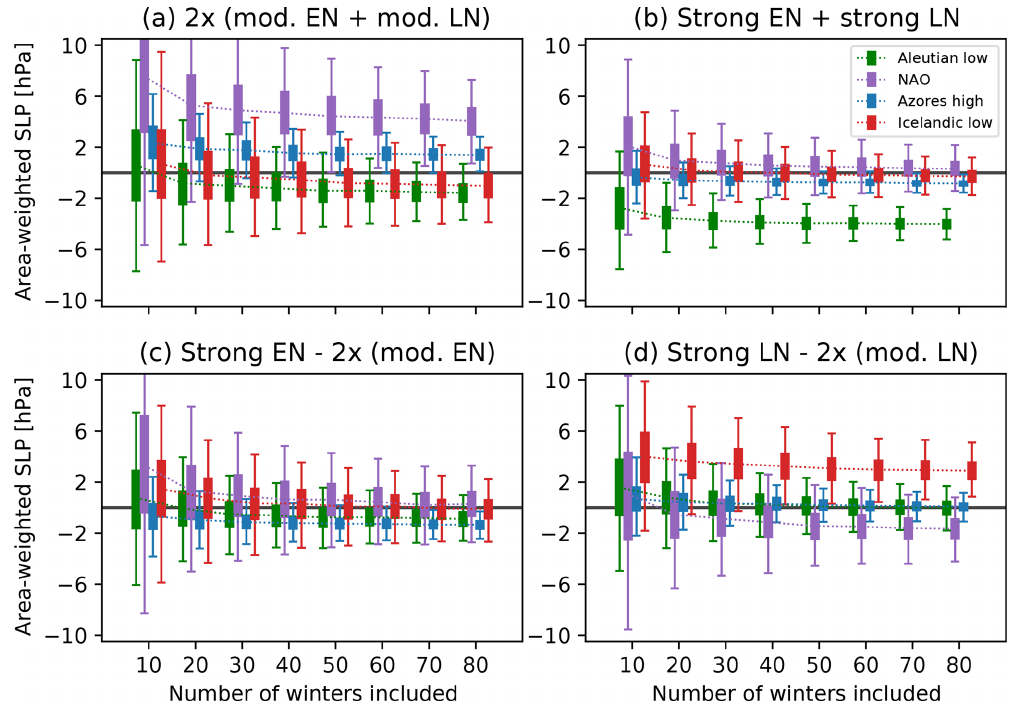
Figure 6. Box plot displaying the 95(50)% confidence intervals indicated by the whiskers (solid boxes) of the DJF model SLP asymmetric response for (a) twice the moderate and (b) strong ENSO forcings when the winter anomalies in these experiments are randomly subsampled in groups of increasing size (shown on the x axis). Colors indicate the different SLP indices (green: Aleutian low, purple: NAO, blue: Azores high, red: Icelandic low). (c) The same as (a, b) but for EN and (d) LN single-phase nonlinearity. When the whiskers do not touch the zero line for a specific sample size and magnitude, then the asymmetry/nonlinearity is statistically detectable at the 95% confidence